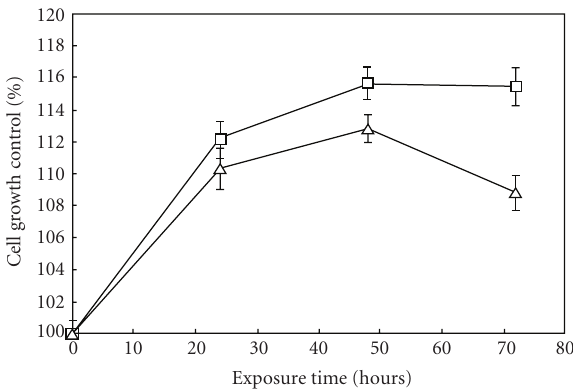
Figure 2: E ff ect of ELF-EMFs exposure on Caco cells proliferation rate. Cells were continuously exposed to 1.0 mT, 50Hz ELF-EMF; control cells were grown under the same conditions in a not energized solenoid. After 24, 48, and 72 hours cells were harvested and counted: the proliferation rate of treated cells was reported as percent of control unexposed cells. Data are mean ± SE of six separate experiments: ( (cid:2) ) 0 μ M TPA; ( Δ ) 0.1 μ M